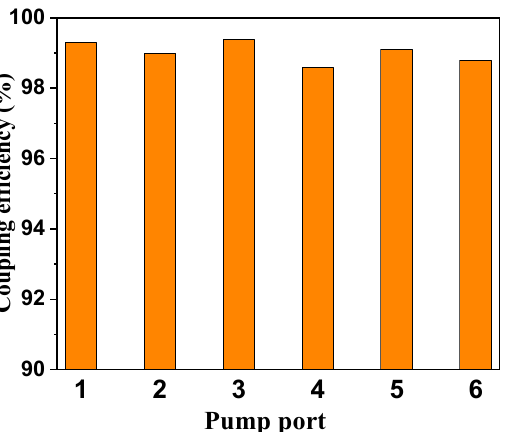
Figure 5. The tests results of the pump coupling efficiency of the pump-signal combiner. The signal performance of the fabricated combiner is tested with a 3 kW fiber laser. The output pigtail of the fiber laser is 25/400 μ m, NA = 0.06/0.46, while the pigtail of the